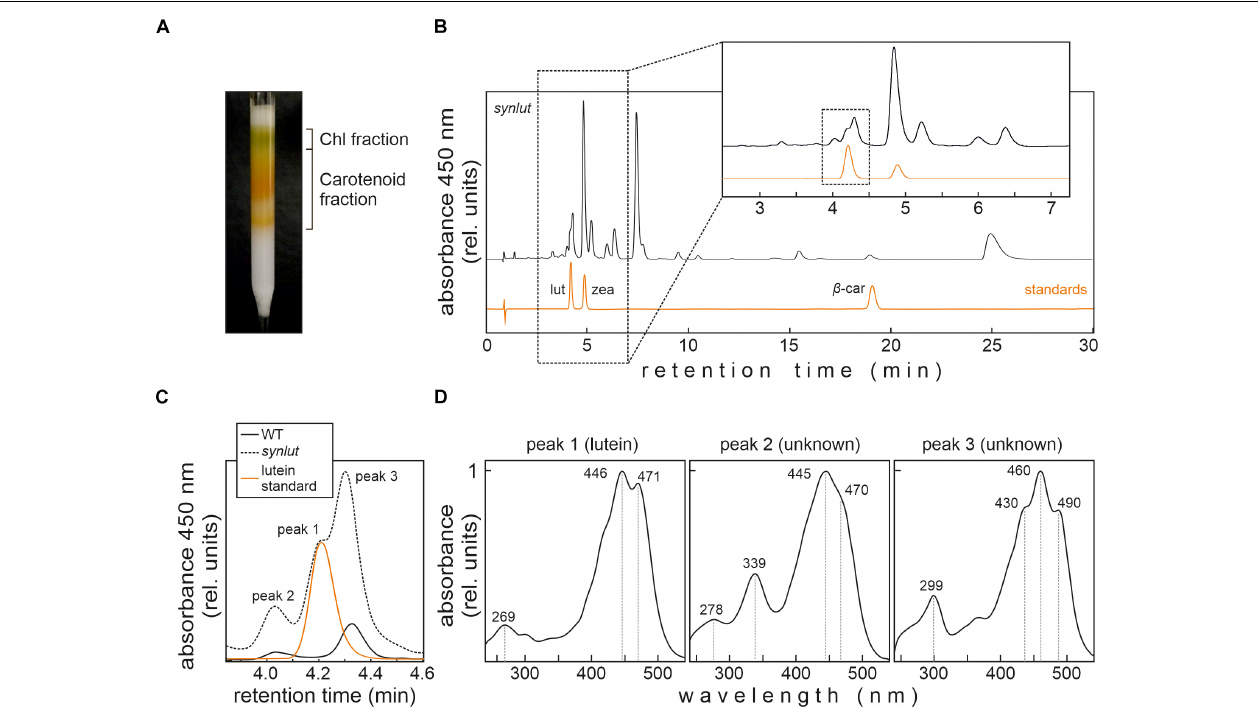
FIGURE 6 | Lutein identification in synlut . (A) Preparative C18 column for extract purification, pre-fractionation and pigment enrichment prior to UHPLC-MS analysis. The two major fractions indicated were collected for further analyses. (B) UHPLC analysis of the synlut carotenoid fraction and a mixture of the indicated standards (lut, lutein; zea, zeaxanthin; β -car, β -carotene). Separation was followed by recording the absorbance at 450 nm over 30 min. An expanded view of the separation of pigments with retention times between ∼ 2.5 and 7.0 min is shown (highlighted by the dotted box). (C) Enlarged view of the interval shown by the dotted box in (B) , showing the lutein standard and peaks identified in synlut and wild-type (WT) samples. (D) Absorption spectra of three peaks with similar retention times to lutein identified in synlut